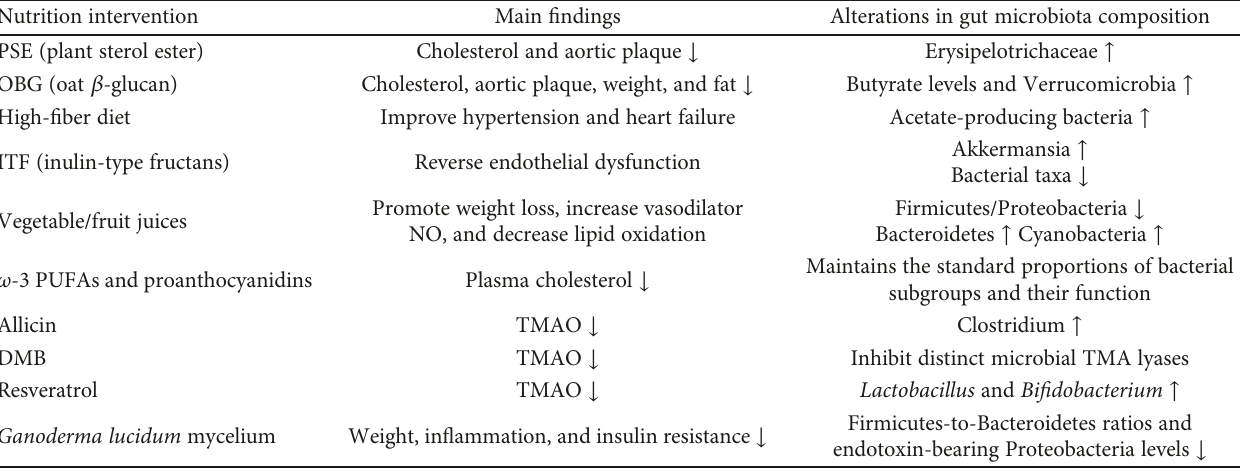
Table 3: Nutrition intervention alters gut microbiota composition and improves